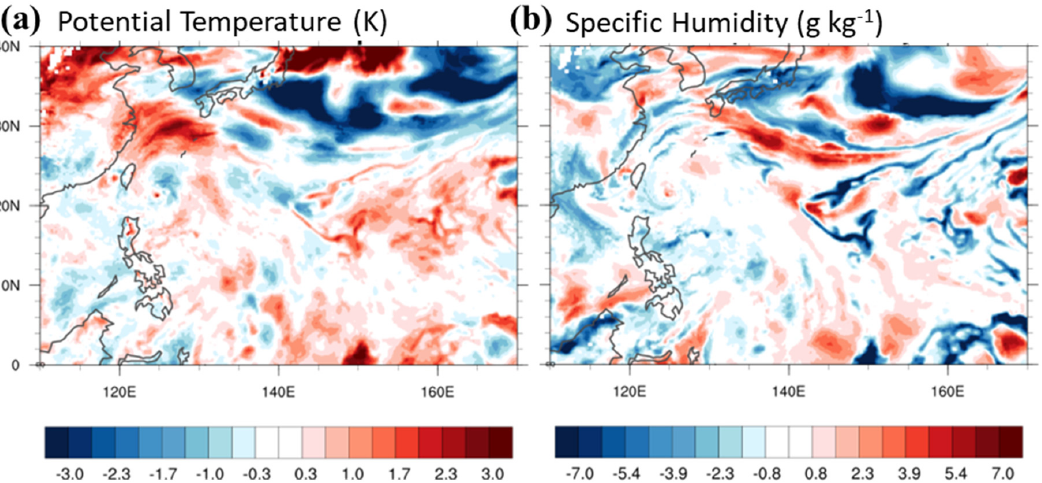
Figure 14. The differences in ( a ) potential temperature (shaded in K) and ( b ) specific humidity (shaded in g kg − 1 ) at 850 hPa between BND_RVH (with the higher resolution of 60-15-3 km) and the ERA-Interim at 0000 UTC 7 July 2016.